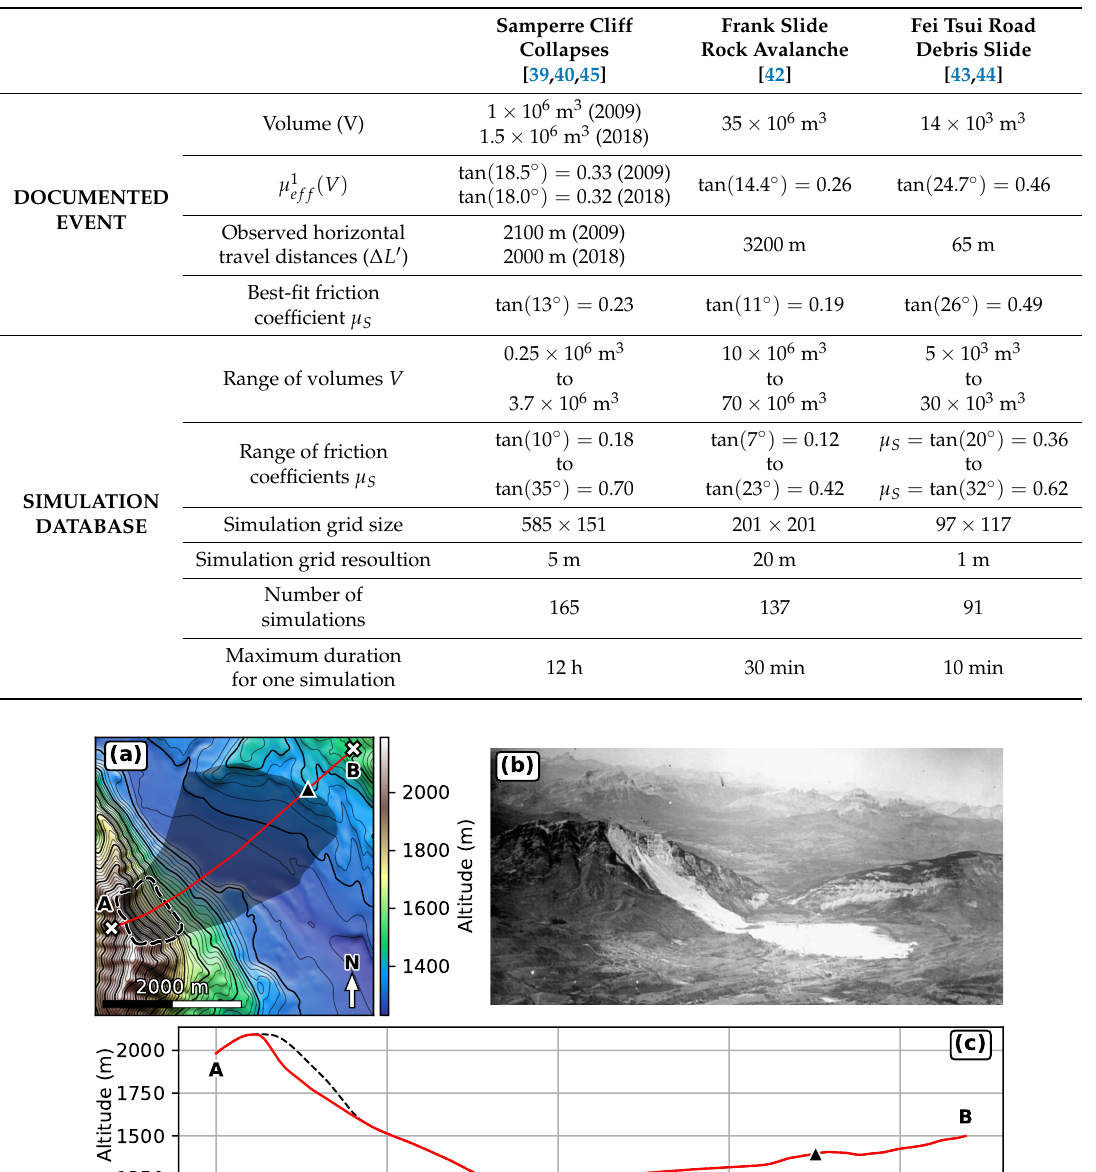
Table 1. Description of the case studies considered in this work. We give the characteristics of the ( V ) gives the effective friction coefficient documented landslides and of the simulation databases. µ 1 ef f estimated from the landslide volume, using the power law deduced for DB1 (see Figure 5b). For the Samperre case study, we give the estimated volumes and travel distances for the 2009 and 2018 collapses (date in brackets).